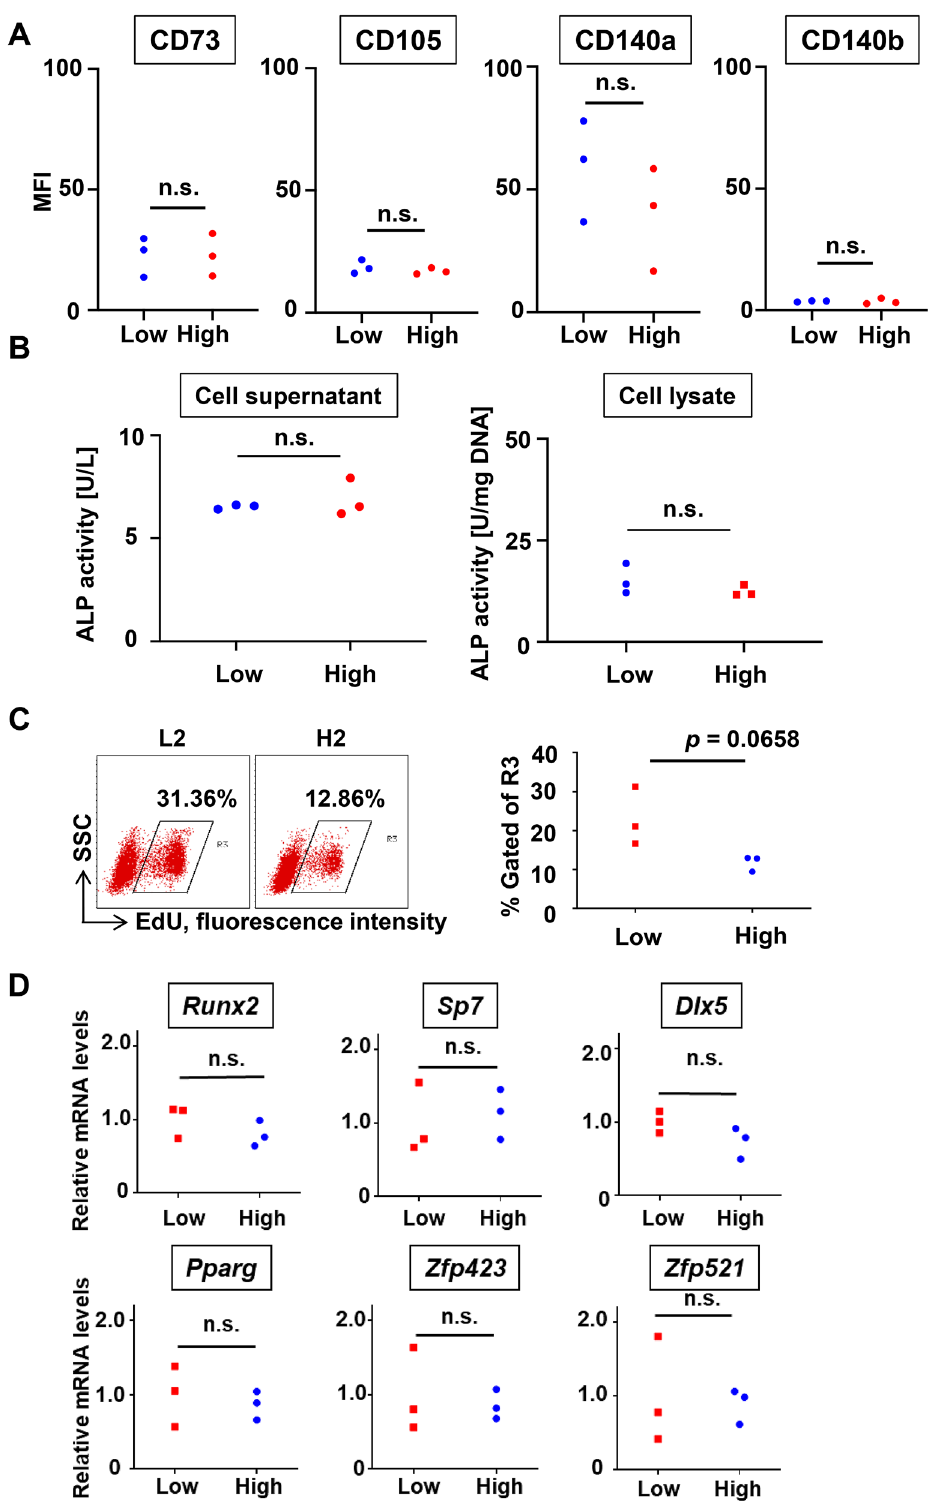
Figure 2. Characterization of progenitor clones with high (high clones) and low (low clones) osteogenic potential. ( A ) Flow cytometry analysis of stem/progenitor markers (CD73, CD105, CD140a, CD140b), showing mean fluorescence intensity (MFI) values, was performed. ( B ) Alkaline phosphatase activity in the cell supernatant (left) and lysate (right) was compared between the high and low clones. ( C ) The representative dot plots of in vitro EdU proliferation assay are shown (left). MFI values of all clones are shown (right, n = 3 clones). ( D ) The relative mRNA expression levels of cellular differentiation-related genes were determined by quantitative reverse transcription-polymerase chain reaction. The expression level of each gene relative to the mean value of L1-3 expression, which was set to 1, is shown. n.s., not significant. Statistical analysis was performed using GraphPad Prism v9.0.2 (www. graph pad.